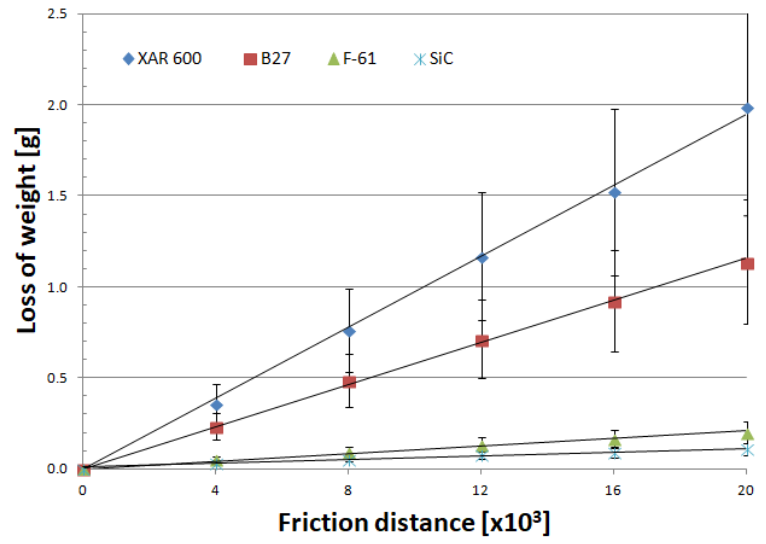
Figure 7. Mass wear as a function of friction distance for materials in light soil.